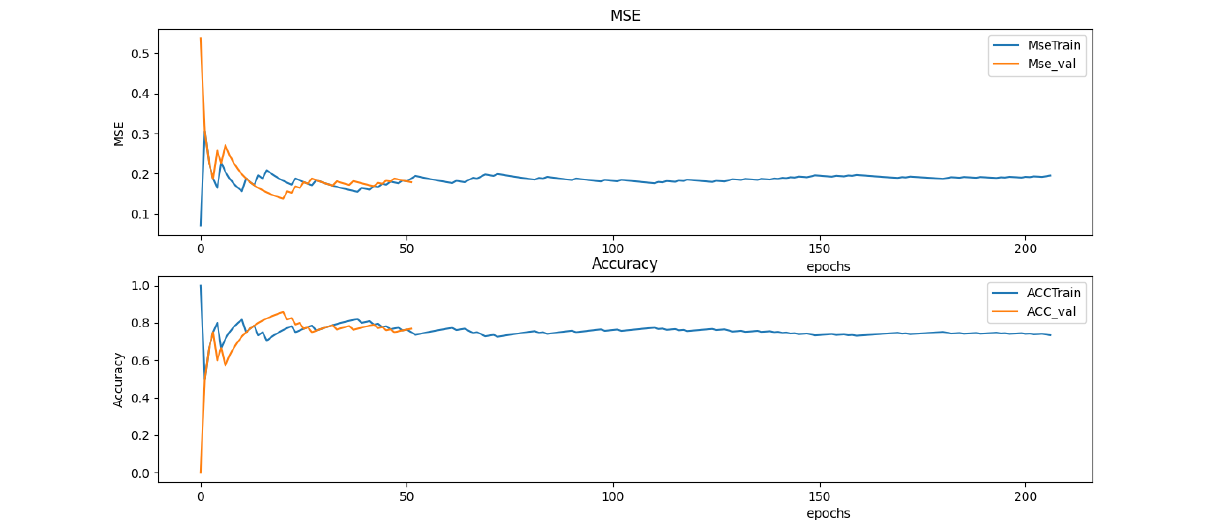
Figure 3. Machine learning algorithm shows increased accuracy and decreased MSE values over the first 50 training rounds (ie, epochs) for predicting PQOL through accessibility skills of HL (Accuracy: 0.92, MSE: 0.07)